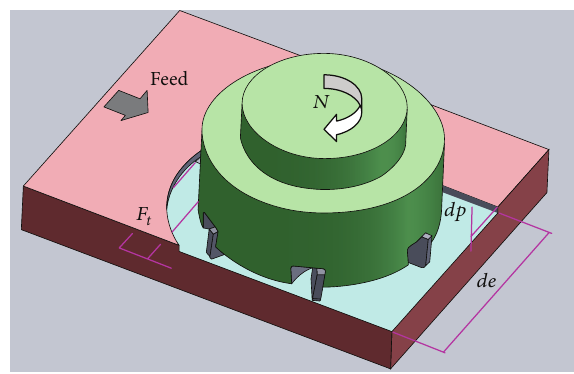
Figure 1: Diagram of cutting